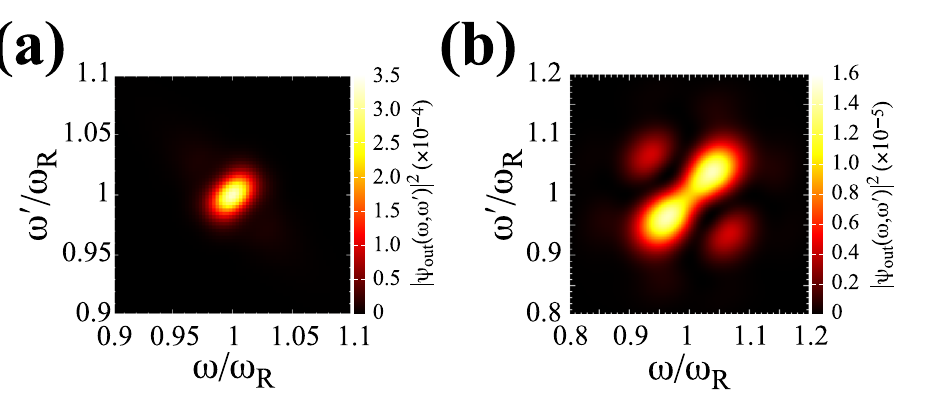
Figure 4. ( a ) E as a function of σ for aluminium nanospheres of a = 10, 15 and 20 nm. ( b ) ψ ω ω ′ ( , ) the maximal E for a = 20 nm. The solid lines in ( a ) are to guide the reader’s eye.